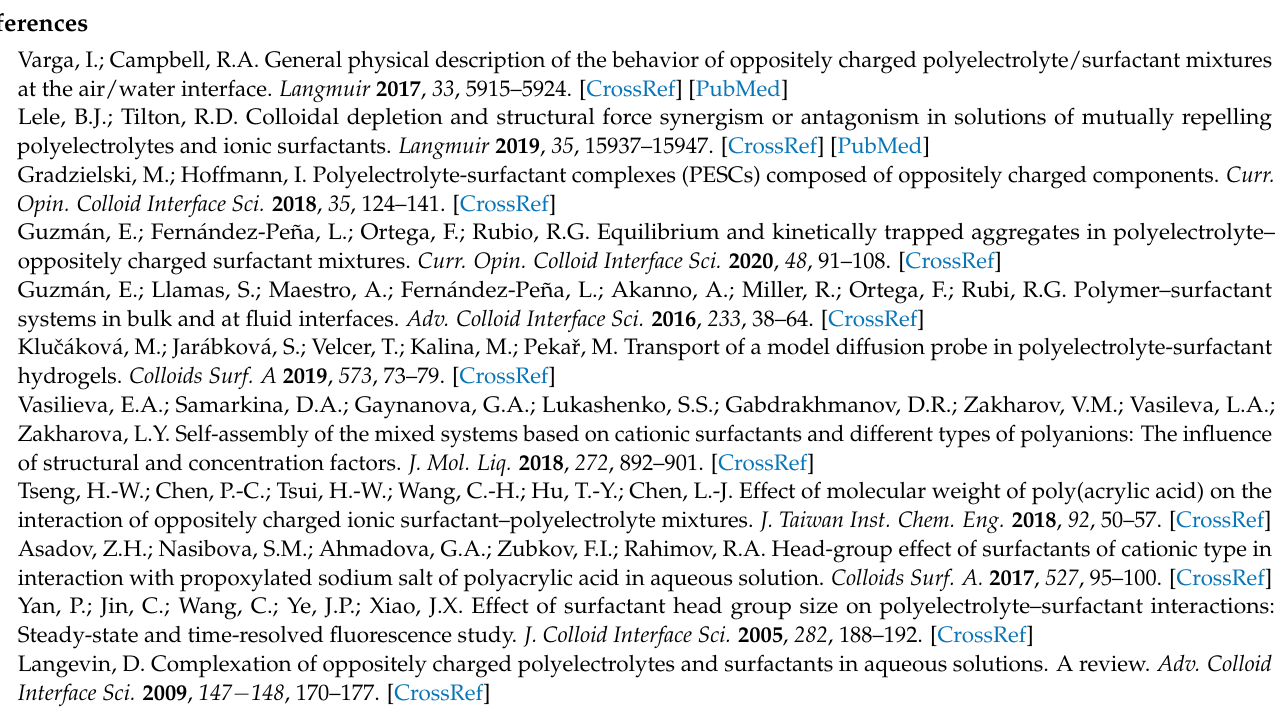
25 ◦ C. Figure S3: DLS correlation functions for the IA-12/PAA binary system at various amphiphile concentrations and a constant PAA concentration; C PAA = 1 mM; 25 ◦ C. Figure S4. DLS correlation functions for the IA-12/PAA binary system at various amphiphile concentrations and a constant PAA concentration; C PAA = 3 mM; 25 ◦ C. Figure S5: DLS correlation functions for the IA-12/PAA binary system at various amphiphile concentrations and a constant PAA concentration; C PAA = 5 mM; 25 ◦ C. Figure S6: Zeta potential versus IA-12 concentration plot for the IA-12/PAA binary systems; 25 ◦ C (the linear X-axis). Figure S7: pH changes in IA-12/PAA aqueous solutions; 25 ◦ C. Figure S8: Molecular weight marker O’Gene Ruler DNA Ladder Mix. Figure S9: Electrophoretic mobility of pDNA in complex with CTAB. Ctrl shows pure pDNA, N/P ratios are indicated above the corresponding wells. A DNA ladder from 100 to 10,000 bp was used. Figure S10: Intensity-averaged size distribution for the IA-12/pDNA system; N/P ratio of 10:1; 25 ◦ C. Figure S11: Intensity-averaged size distribution for CTAB/pDNA system; N/P ratio of 10:1; 25 ◦ C. Figure S12: Zeta potential for IA-12/pDNA (green) and CTAB/pDNA (red) complexes; N/P ratio of 10:1; 25 ◦ C. Figure S13. EB/oNu emission fluorescence spectra in the presence of various amounts of IA-12 (the arrow indicates the direction of the increase in the amphiphile concentration); 25 ◦ C. Figure S14: Typical turbidimetric plot for DPPC liposomes in the absence and in the presence of IA-12 (the amphiphile/lipid molar ratio is 1:5), C DPPC = 0.7 mM